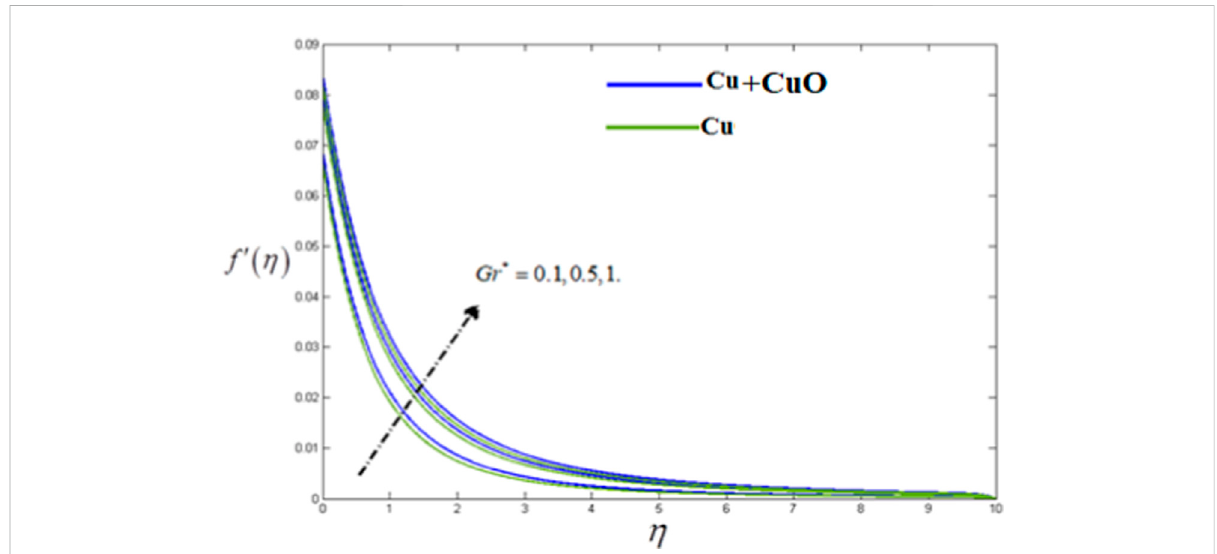
FIGURE 6 Gr * versus ( f ′ ( η ) ). When, k (cid:2) 0 . 2 , Λ (cid:2) 0 . 4 , ϕ 1 , ϕ 2 (cid:2) 0 . 02 , Rd (cid:2) 0 . 3 , B i (cid:2) 0 . 1 , Pr (cid:2) 6 . 2.